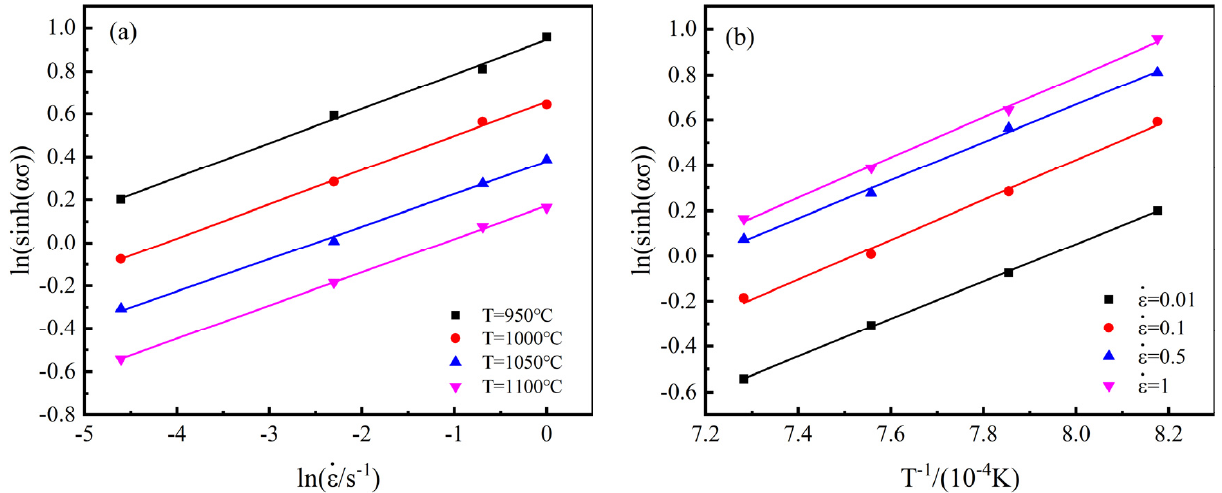
(cid:0) . (cid:1) ε vs. ln [ sinh ( ασ )] ; ( b ) Q /R n by plotting ln [ sinh ( ασ )]